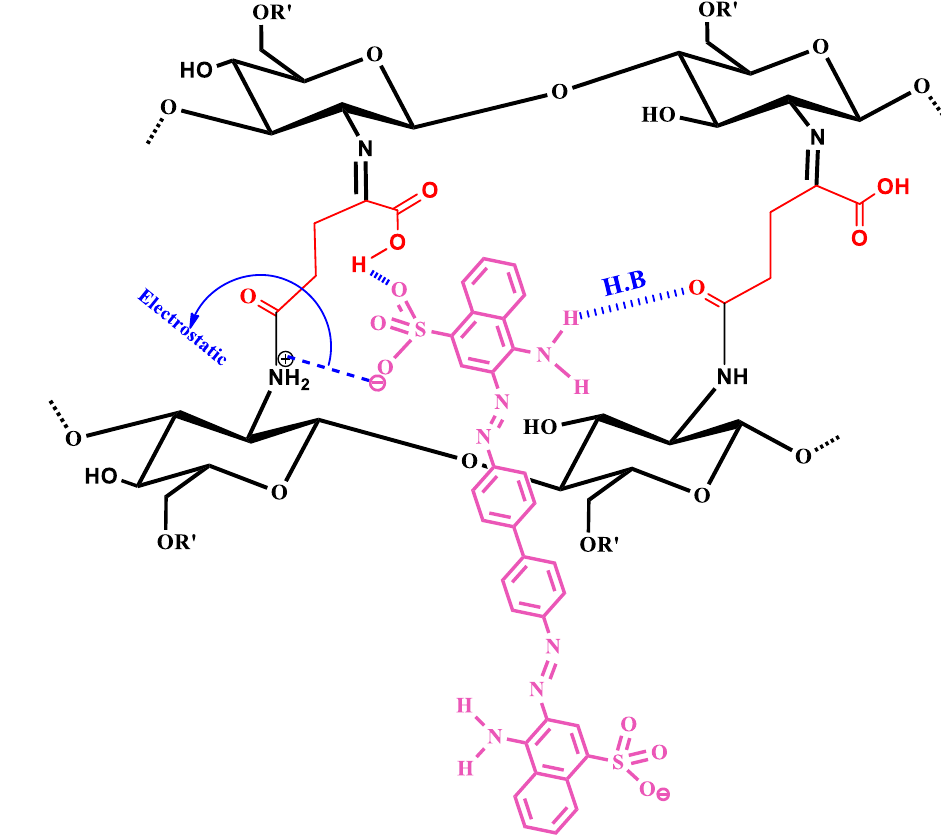
Fig. 8 A schematic representa- tion for the adsorption mecha- nism of CR on α